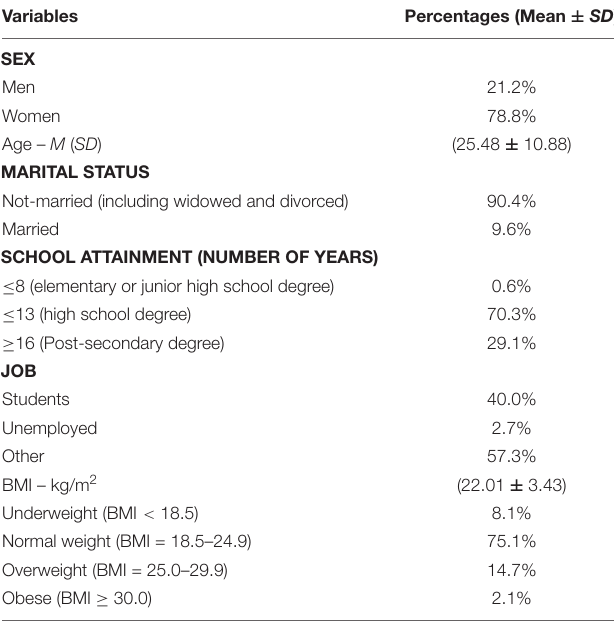
TABLE 1 | Characteristics of the sample ( n =